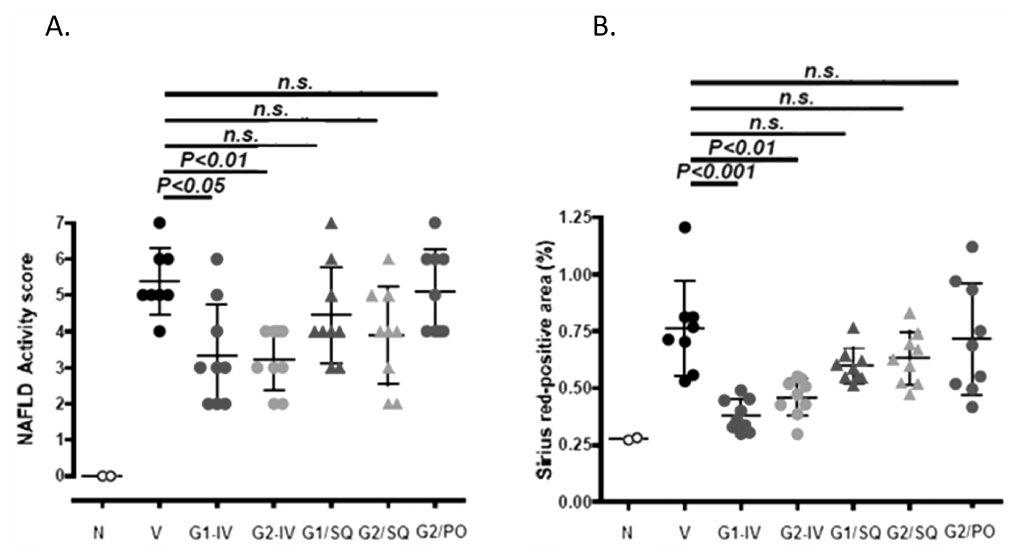
Figure 5. Evaluation of route of administration of GR-MD-02. N: normal mice. Treatments included vehicle (V) (0.9% NaCl three times weekly from weeks 6–9), and intravenous doses of two preparations of GR-MD-02 (40 mg/kg three times weekly from weeks 6–9) sterilized by different methods given either intravenously (G1/IV and G2/IV) or subcutaneously (G1/SQ and G2/SQ). Additionally GR-MD-02 was given orally in a dose of 1500 mg/kg daily (G2/PO). A : NAFLD Activity Score; B : Sirius red-positive area. Differences between the vehicle group and the treatment groups were assessed by one way ANOVA followed by Tukey’s Multiple Comparison Test and the Mann-Whitney U test (shown in parentheses). P values , 0.05 were considered significant and results expressed as mean 6 SD.